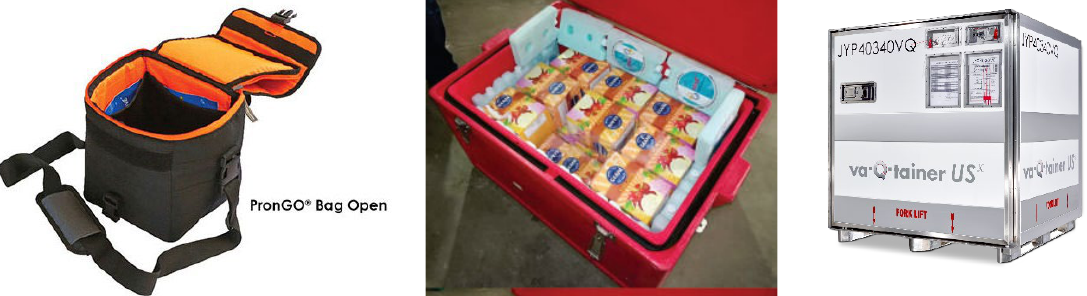
Figure 10. PronGO ® bag and box (source: both PLUSS Advanced Technologies Ltd.) and va-Q-tainer for large volumes (source: va-Q-tec AG).